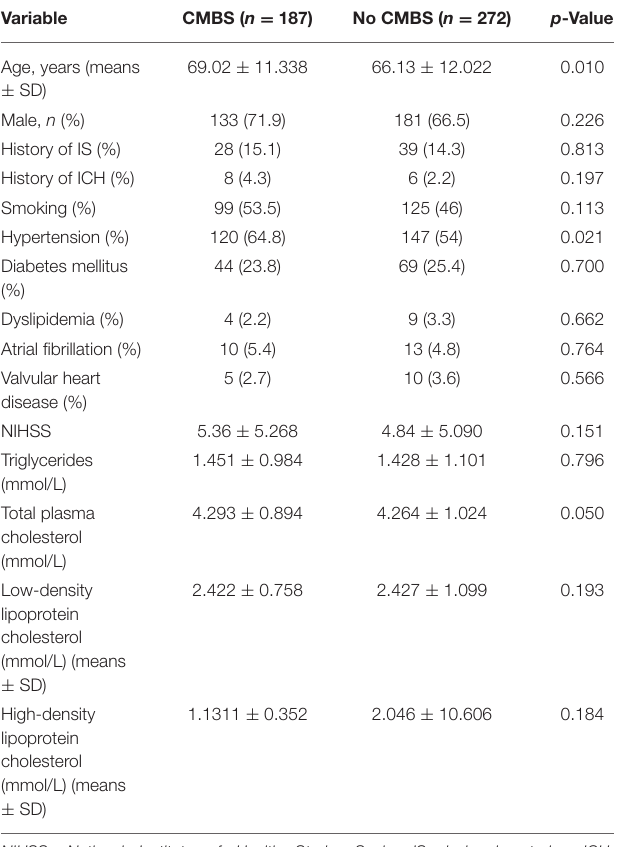
TABLE 1 | Patient demographics and medical data.